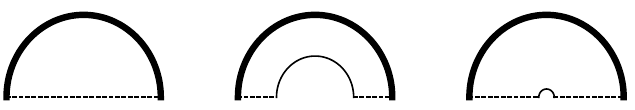
Figure 4 . Surfaces of constant Killing time and constant azimuthal angle for global AdS 4 (left) and the large (center) and small (right) Schwarzschild-AdS 4 black holes. The upper solid semi-circle is the AdS boundary. When it exists, the smaller solid semi-circle is the horizon. Dashed lines are the azimuthal rotation axes. Horizons and rotation axes are exchanged under double Wick rotations. Interpreting solid lines as rotation axes and dashed lines as horizons, these (cid:12)gures thus also depict static slices of spacetimes with BTZ boundary black holes corresponding to the funnel (left) and short (center) and long (right) droplet phases discussed in the